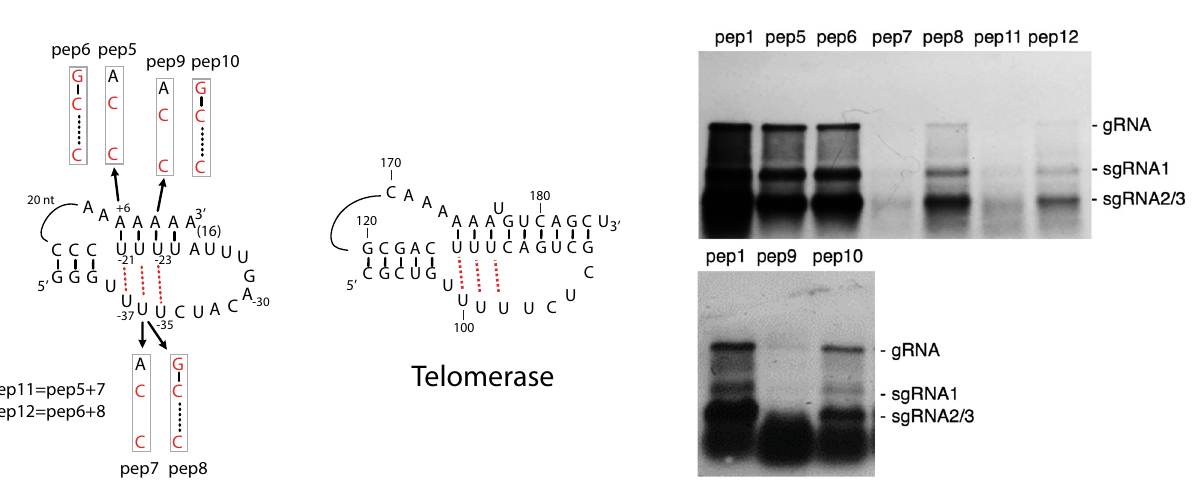
Figure 5. Putative UAU triples in PepMV by analogy to the human telomerase pseudoknot. Northern blots showing the accumulation of PepMV gRNA and sgRNAs in N. benthamiana protoplasts after transfection with the indicated